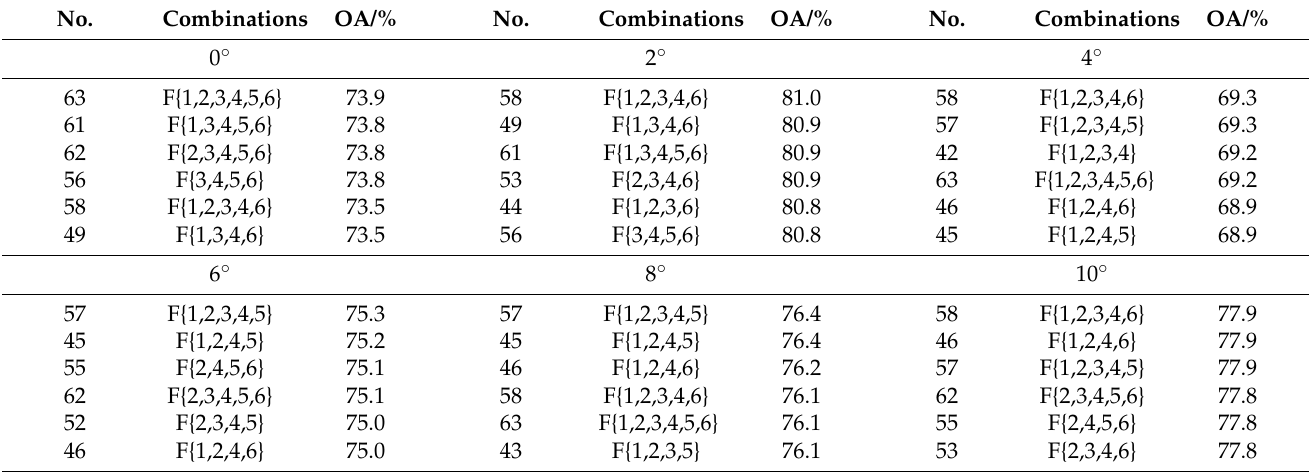
Table 7. Overall accuracies of the top six multifeature combinations at small incidence